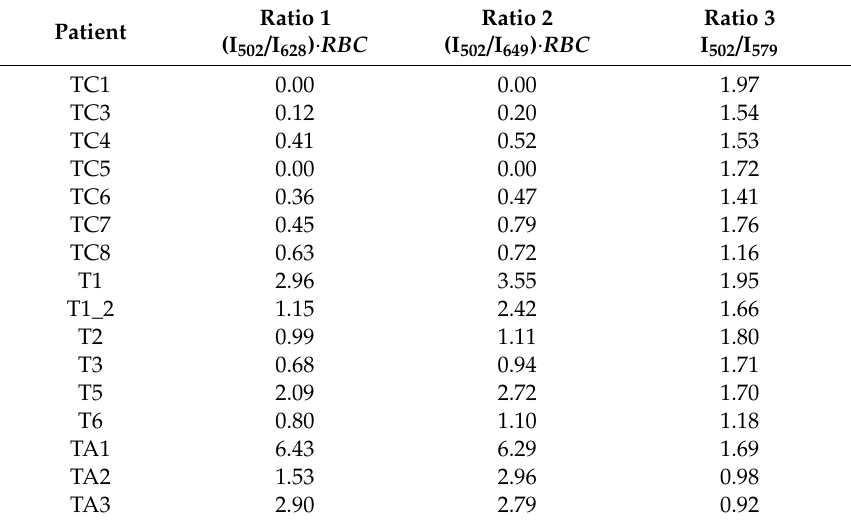
Table 3. Averaged ratios for main emission peaks. I λ : intensity at di ff erent wavelengths; RBC : average number of RBCs per